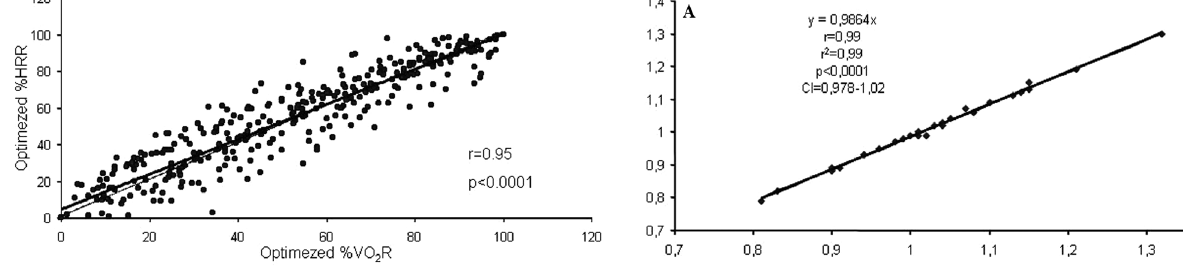
Figure 1 - Relationship between percentage of heart rate reserve (%HRR) and percentage of oxygen consumption reserve (%VO R) in optimized 2 heart failure patients. The plot represents stage by stage regression of the cardiopulmonary exercise test. The dotted is the identity line, the full line is regression line Figure 3 - Linear regression between 0 intercept and 1 intercept HR slope of each optimized(A) and non-optimized(B) heart failure patient Figure 2 - Relationship between percentage of heart rate reserve (%HRR) and percentage of oxygen consumption reserve (%VO R) in non-optimized heart 2 failure patients. The plot represents stage by stage regression of the cardio- pulmonary exercise test. The dotted line is the identity line, the full line